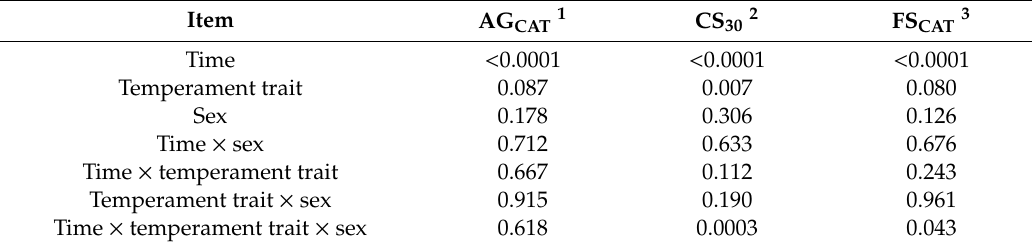
Figure 7. Twenty-seconds mean (±SEM) rectal temperature (T REC , °C) of heifers (gray line) and steers (black line) with flight speeds of FS ≤ 1.6 (n = 13; ♀ = 2, ♂ = 11); FS 1.7 ≤ 2.5 (n = 23; ♀ = 14, ♂ = 9); and FS ≥ 2.6 (n = 9; ♀ = 6, ♂ = 3). Table 4. Interactions ( p -values) for agitometer score category (AG CAT ), crush score (CS), and flight speed category (FS CAT )